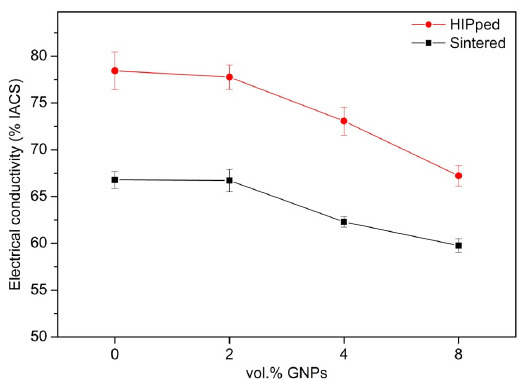
Figure 13. The electrical conductivity of pure Cu and Cu-GNPs nanocomposites vs. vol % of GNPs for as-sintered and hot isostatic presses (HIPed) specimens, reproduced from [8], with permission from Springer Nature, 2018. IACS, International Annealed Copper Standard. Table 6. A summary of the electrical conductivity of copper composites reinforced with different types and vol % of reinforcements. SPS, spark plasma sintering.